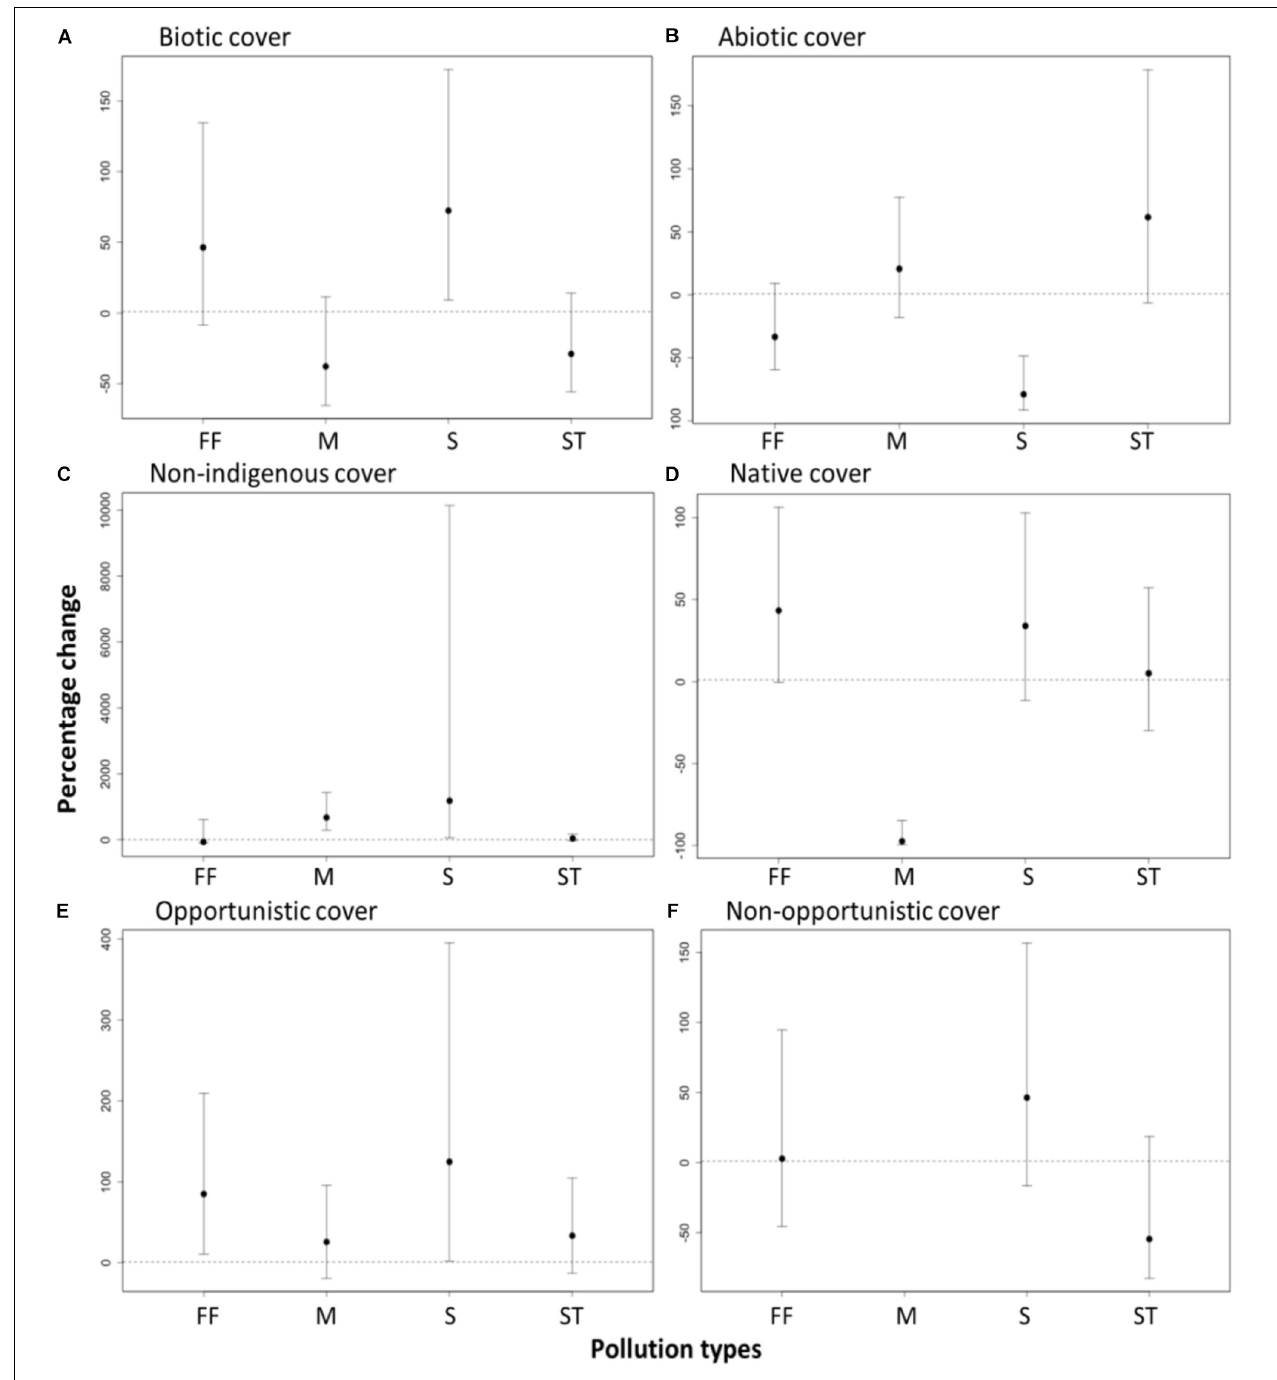
FIGURE 4 | Effects of pollution from anthropogenic point sources [fish farms (FF), marinas (M), sewage outfalls (S), and storm water drains (ST)] on the change in percentage cover of recruited (A) biotic species (i.e., visible algae and sessile invertebrates), (B) abiotic (bare space and sediment), (C) non-indigenous species (D) native species, (E) opportunistic species and (F) non-opportunistic species. Effects are significant if confidence intervals do not overlap zero. Percentage change was calculated from the GLMM estimates based on a quasi-binomial, mixed effect model with a log